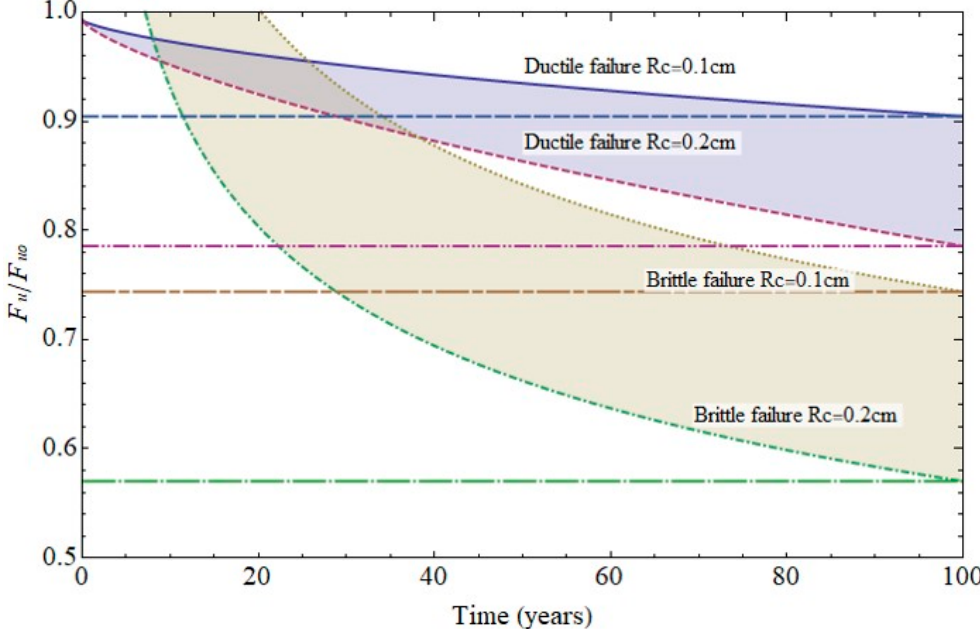
Figure 13. Variation in (6 mm diameter) rebar strength over time due to pitting (ductile failure) or cracking (brittle failure).